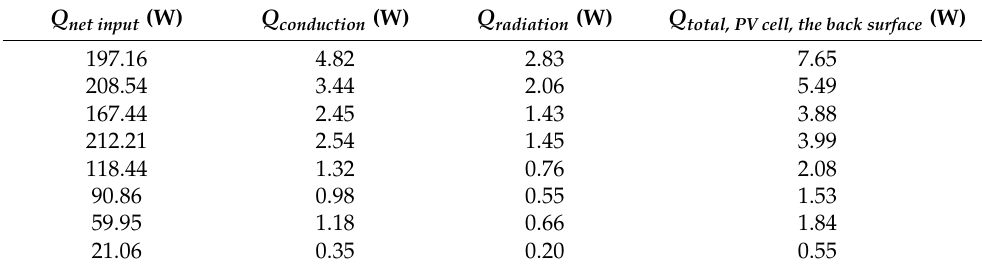
Table 5. Heat transfer due to convection and radiation from the back surface of the PV